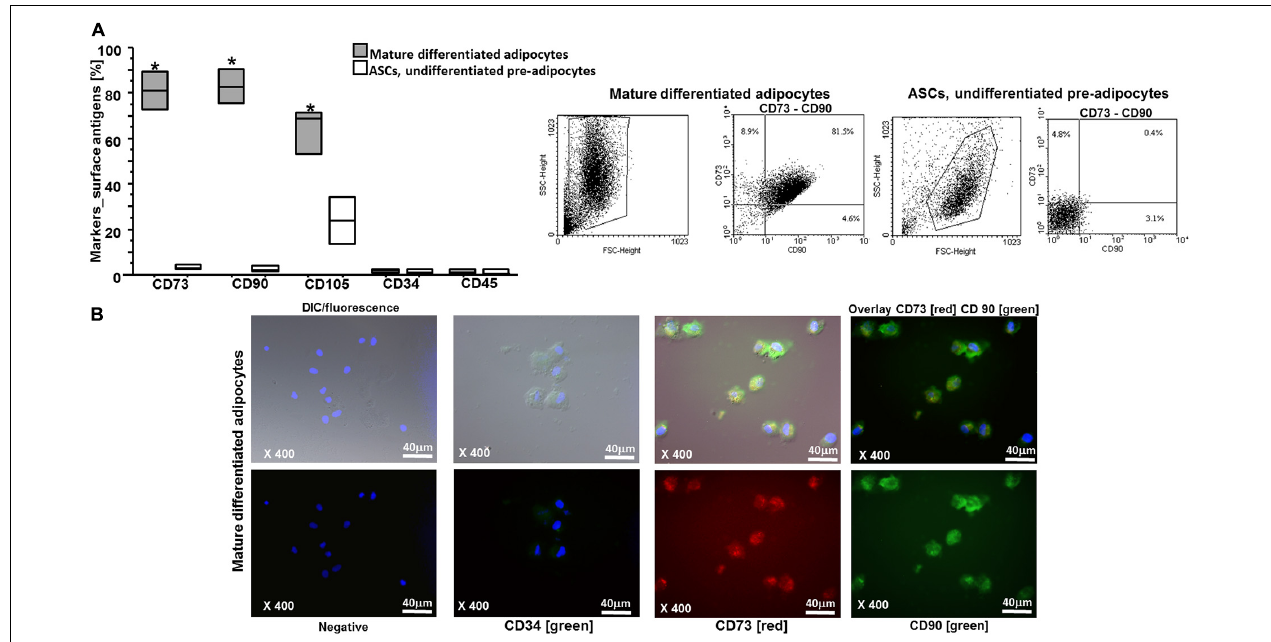
FIGURE 2 | (A) Flow cytometry analysis on ASCs and on mature differentiated adipocytes for antigen surface markers: the results are shown as box-plots with medians (lines inside the boxes), mature differentiated adipocytes significantly expressed CD105, CD73, and CD90 in comparison with ASCs (* p = 0.0272 for CD105, ** p < 0.0001 for CD73, and CD90; n = 3 experiments). Analysis of variance (ANOVA), Fisher’s PLSD. Right, representative examples of flow cytometric analysis in ASCs and in adipocytes. The numbers indicate the percentage of double positive cells for CD73 and CD90. (B) Representative immunofluorescence for antigen surface markers on mature differentiated adipocytes is shown: higher, differential interference contrast (DIC-Nomarski) combined with DAPI and fluorescence; lower, DAPI with fluorescence; negative, CD34 (green), CD73 (red), and CD90 (green) (magnification at × 400, scale bar = 40 µ m). Axioskop-2-Zeiss